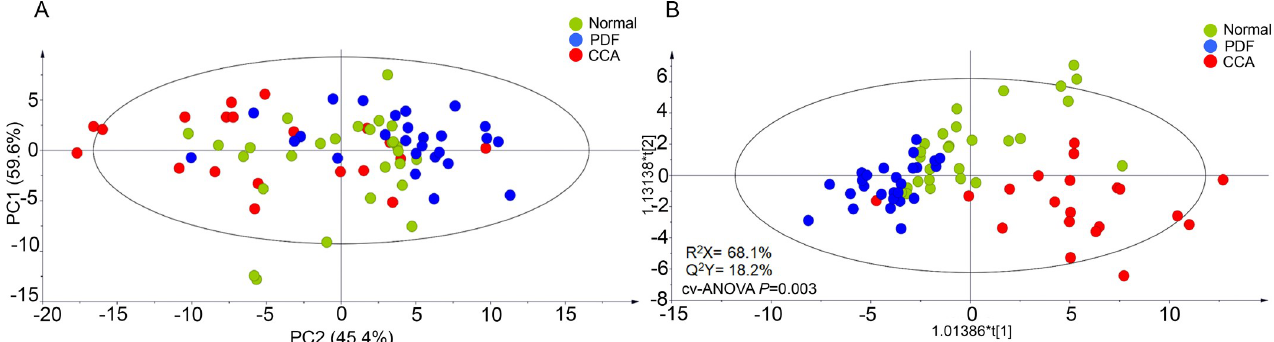
Fig 3. Biomarker qualification and multivariate analysis. (A) and (B) PCA and O-PLS-DA score plots of MRM results of urinary candidates that show sample differentiation; normal pathology (green), PDF (blue) and CCA group (red).